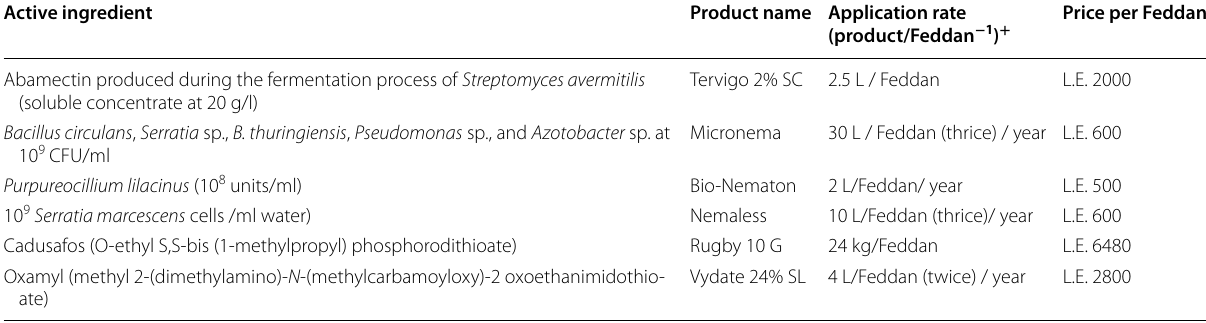
Table 1 Key commercial bionematicides and synthetic nematicides, their practical rates, and prices in Egypt* Active ingredient